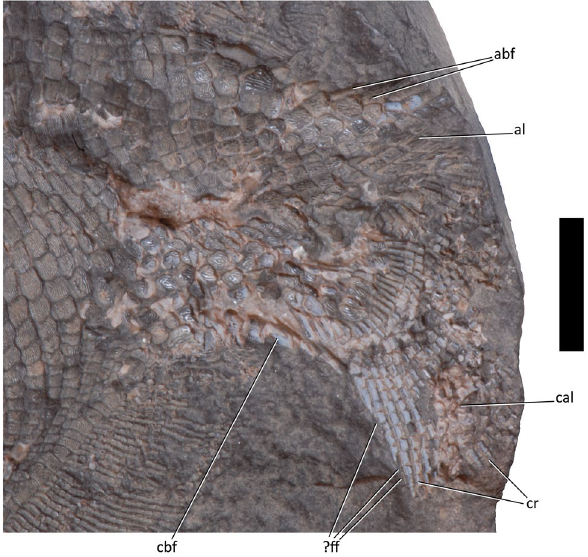
Figure 7. Detail of caudal fin and scales of platysomid specimen NSM 017.GF.017.001. Scale bar = 10 mm. abf, axial basal fulcrum; al, axial lobe; cal, caudal lobe; cbf, caudal basal fulcrum; cr, caudal lobe rays; ?ff, fringing